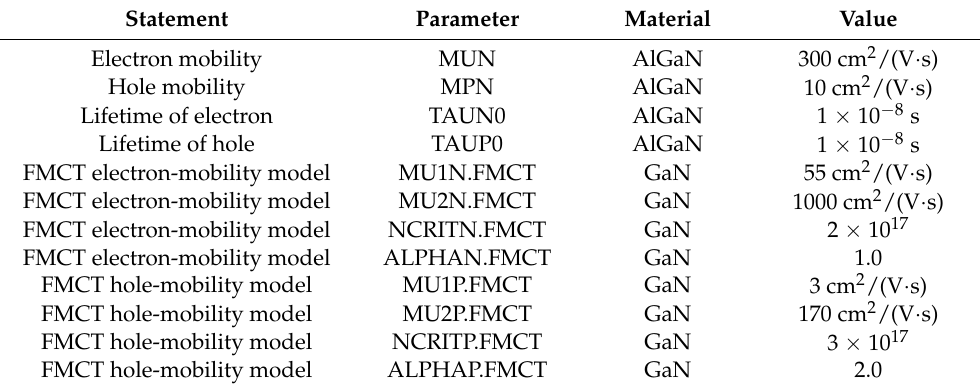
Table 2. Material parameters used in